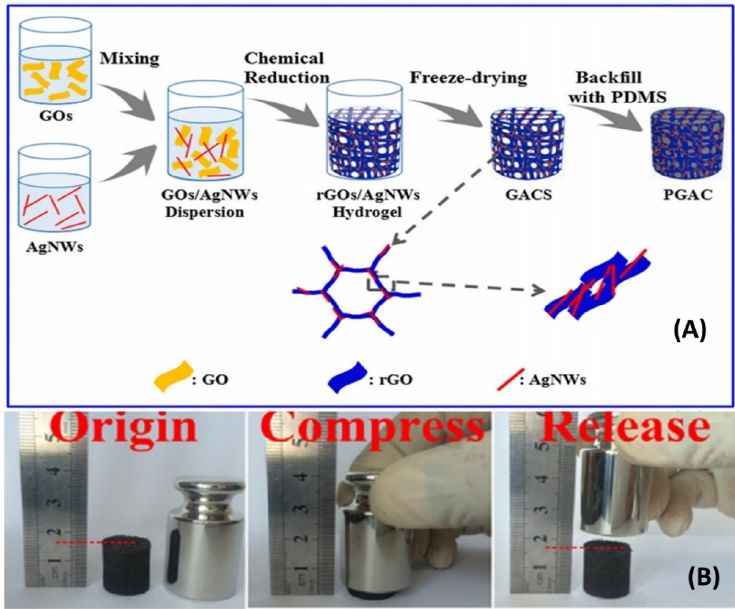
Figure 7. ( A ) Schematic demonstrating the fabrication process of hybrid RGO/AgNW/PDMS monoliths. ( B ) Compression test of hybrid monolith. Reproduced with permission from [107]. Copyright 2019, Elsevier Ltd.